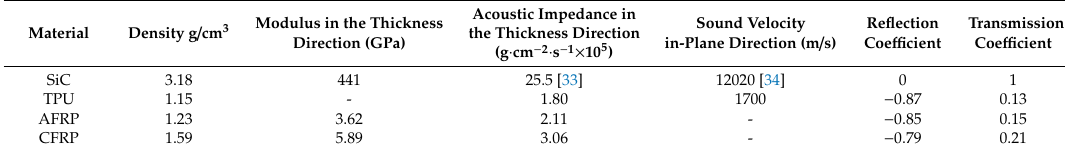
Table 6. Acoustic impedances of intermediate